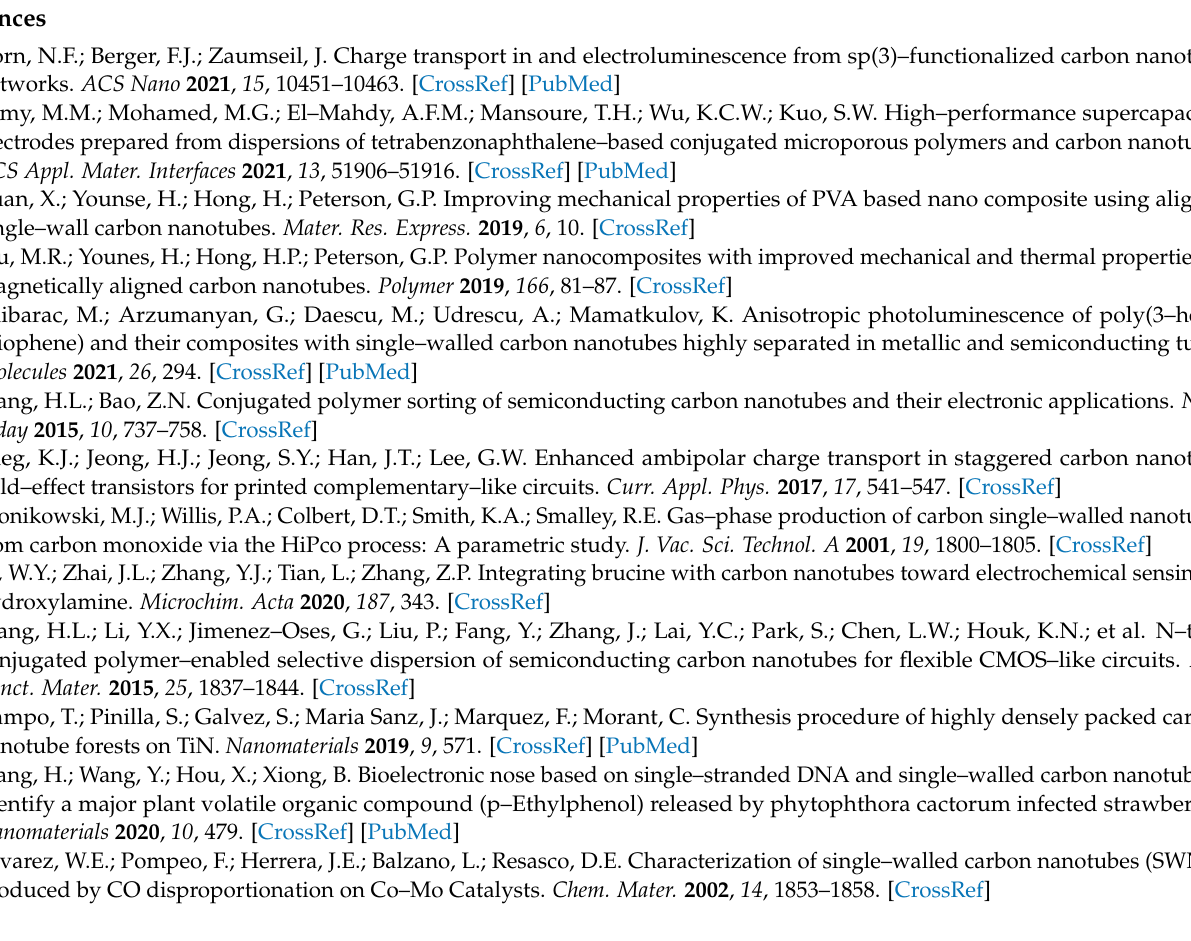
red–brown layer at (a) 458, (b) 514, (c) 532, and (d) 633 nm excitation wavelength in the range of 100–300 cm − 1 , respectively; Figure S15. Gaussian fitting curves for the top green layer at (a) 458, (b) 514, (c) 532, and (d) 633 nm excitation wavelength in the range of 100–300 cm − 1 , respectively; Figure S16. Images of DGU after centrifugation with Ua–PMS as SWNTs dispersant; Table S1. The performance features of DGU separation of SWNTs; Table S2. Information on the chiral indices (n, m) designation of the absorption peaks in Figure S8; Table S3. Summary of Raman chiral assignment information of BA–PMS dispersed SWNTs and top green and bottom brown layers at 458, 514, 532, and 633 nm excitation